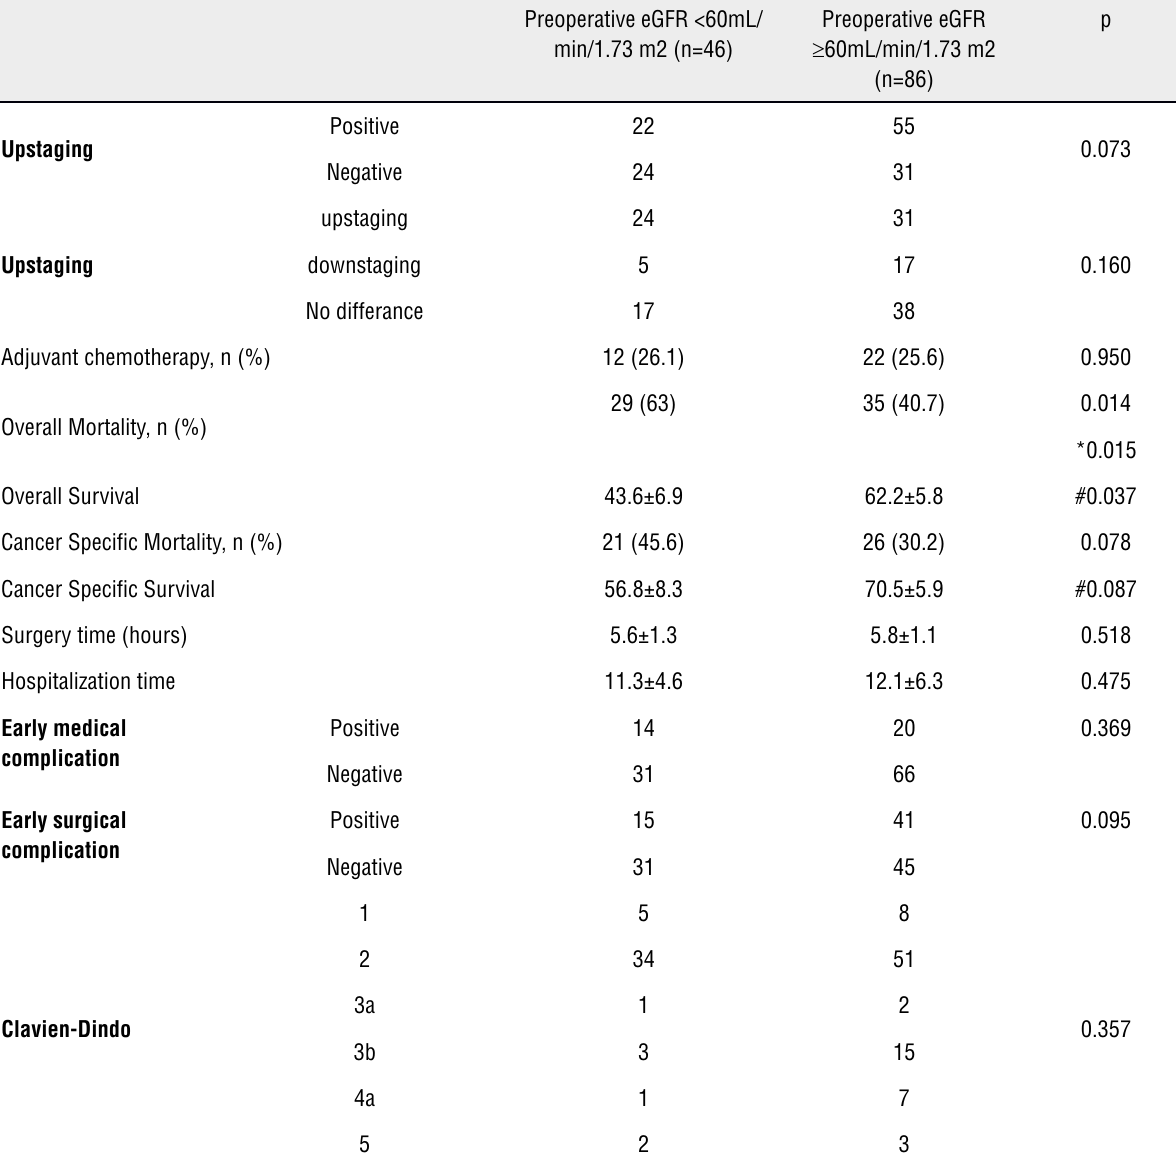
Table 3 - Comparison of postoperative data, complications and survival findings between Group 1 and Group